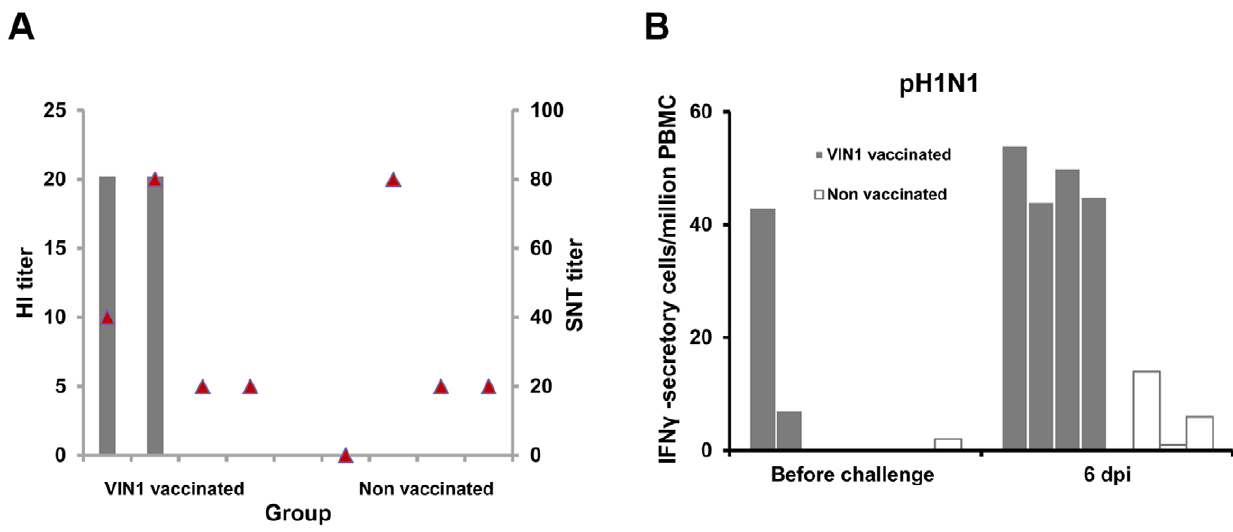
Figure 5. Immunization with the VIN1-HA1 peptide induces specific antibodies and T-cells against the heterologous pH1N1 virus. (A) HI and SNT titers obtained with sera from pigs immunized either with the VIN1-peptides or with saline solution (control), at 6 dpi with the pH1N1 virus. Grey bars represent HI titres and red triangles show SNT. (B) IFN c -ELISPOT using pH1N1 virus as stimulus and PBMCs from pigs immunized either with the VIN1-peptides or with saline solution (control). The assay was done using PBMCs isolated either before the infection with the pandemic H1N1 virus or at 6 dpi.